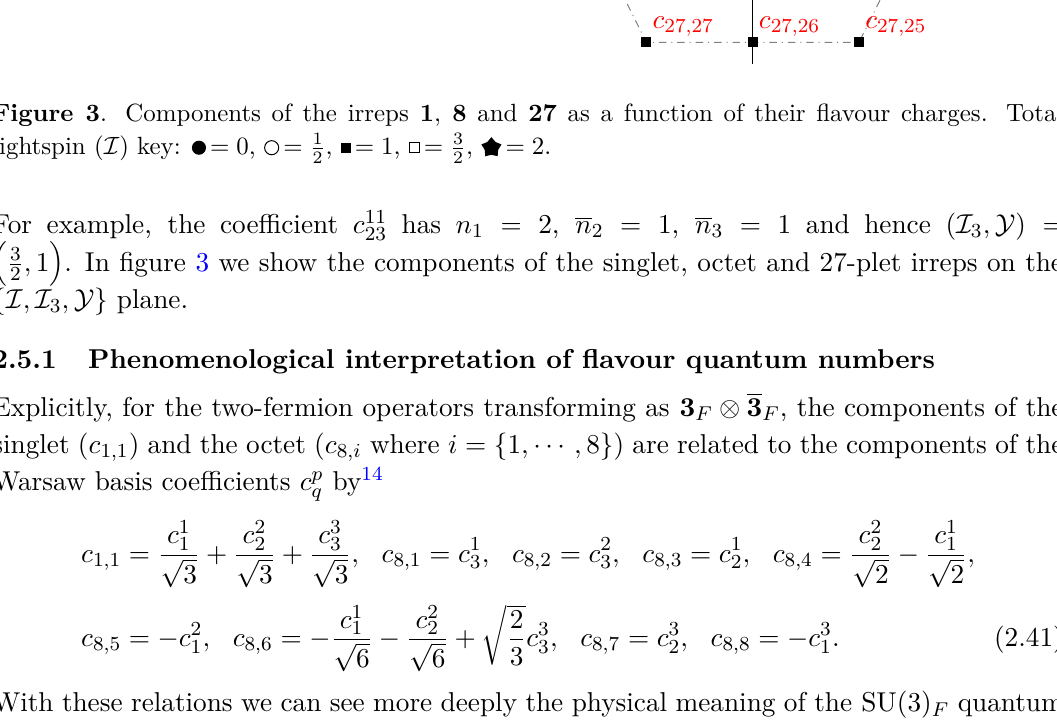
Figure 3 . Components of the irreps 1 , 8 and 27 as a function of their flavour charges. Total lightspin ( I )